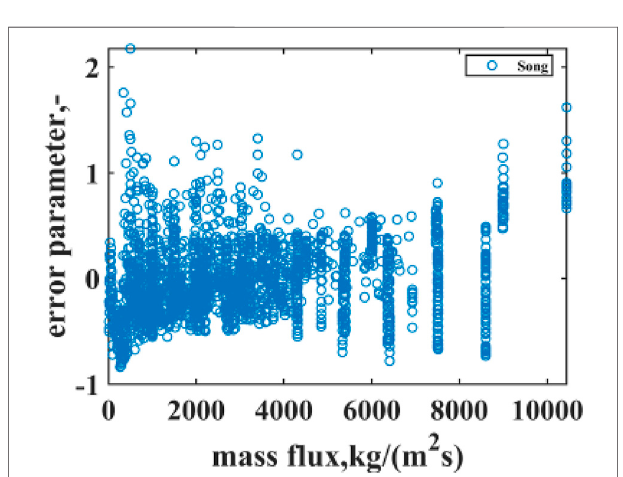
FIGURE 6 | Prediction accuracy of Song correlation (Song et al., 2021a) varied with mass fl ux.